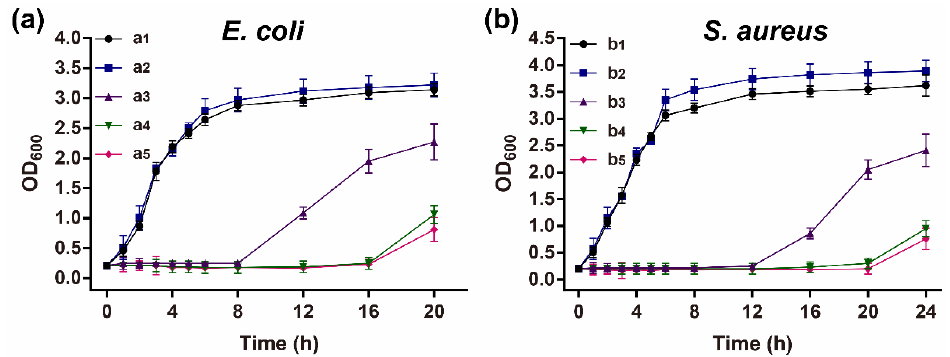
Figure 10. Bacterial growth assay. ( a ) E. coli and ( b ) S. aureus . a1, b1, control; a2, b2, SS/agar film; a3–b5, AgNPs/SS/agar films with UV irradiation for 10 min (a3, b3), 30 min (a4, b4), and 60 min (a5, b5).